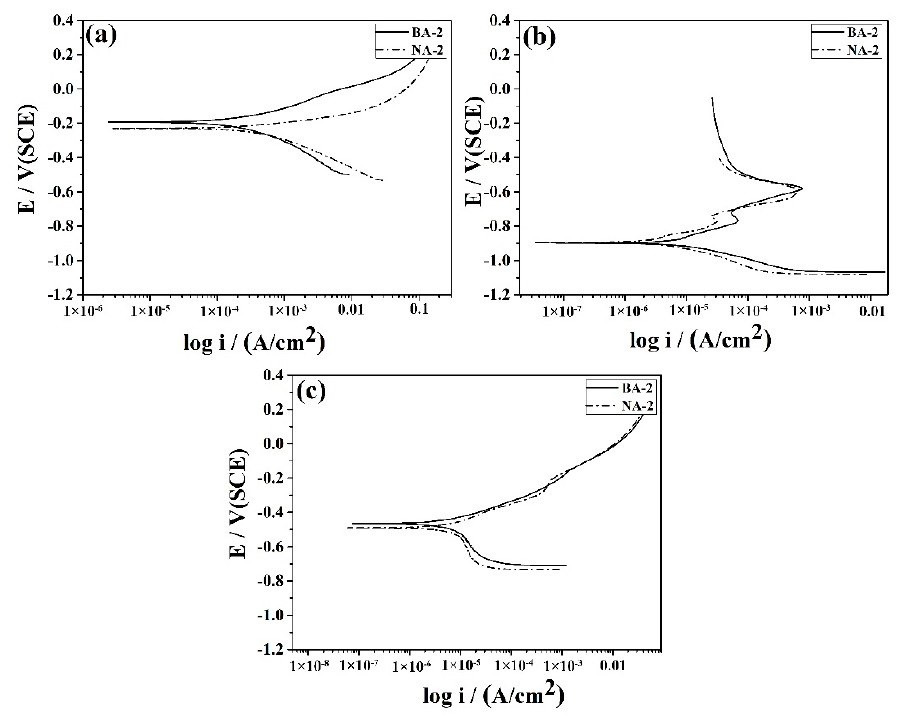
Figure 10. Effect of the boriding process (BA-2) on the potentiodynamic polarization curves in different corrosive mediums: ( a ) 0.5 mol/L HCl; ( b ) 10% NaOH; ( c ) 3.5% NaCl. Table 3. The I corr and E corr of samples BA-2 and NA-2 in different corrosive